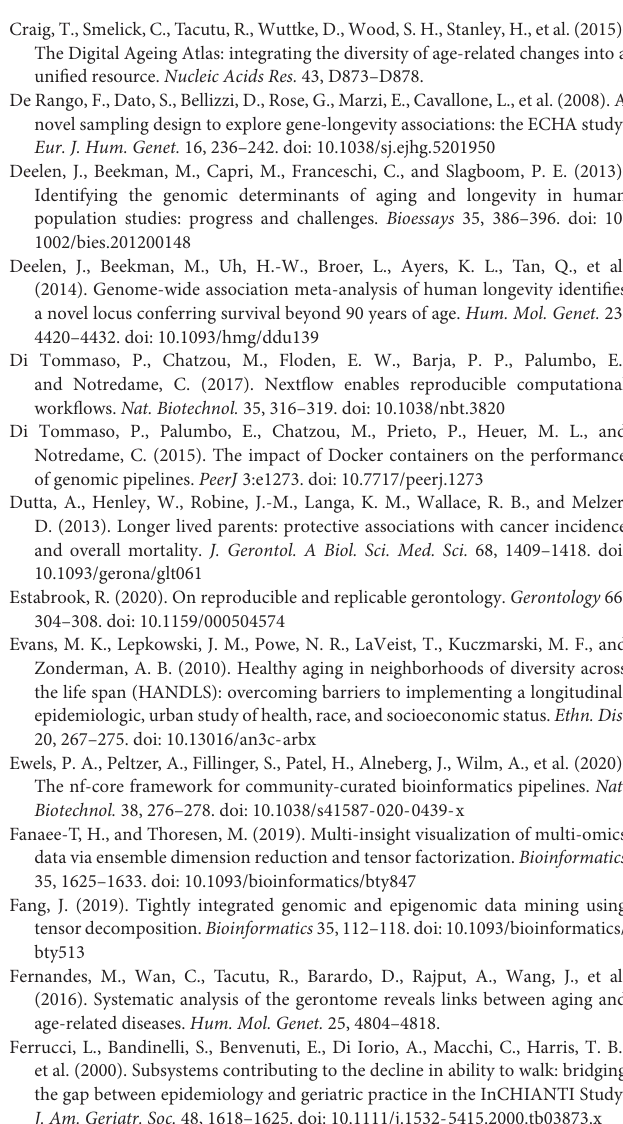
Supplementary Table 1 | Available datasets in aging